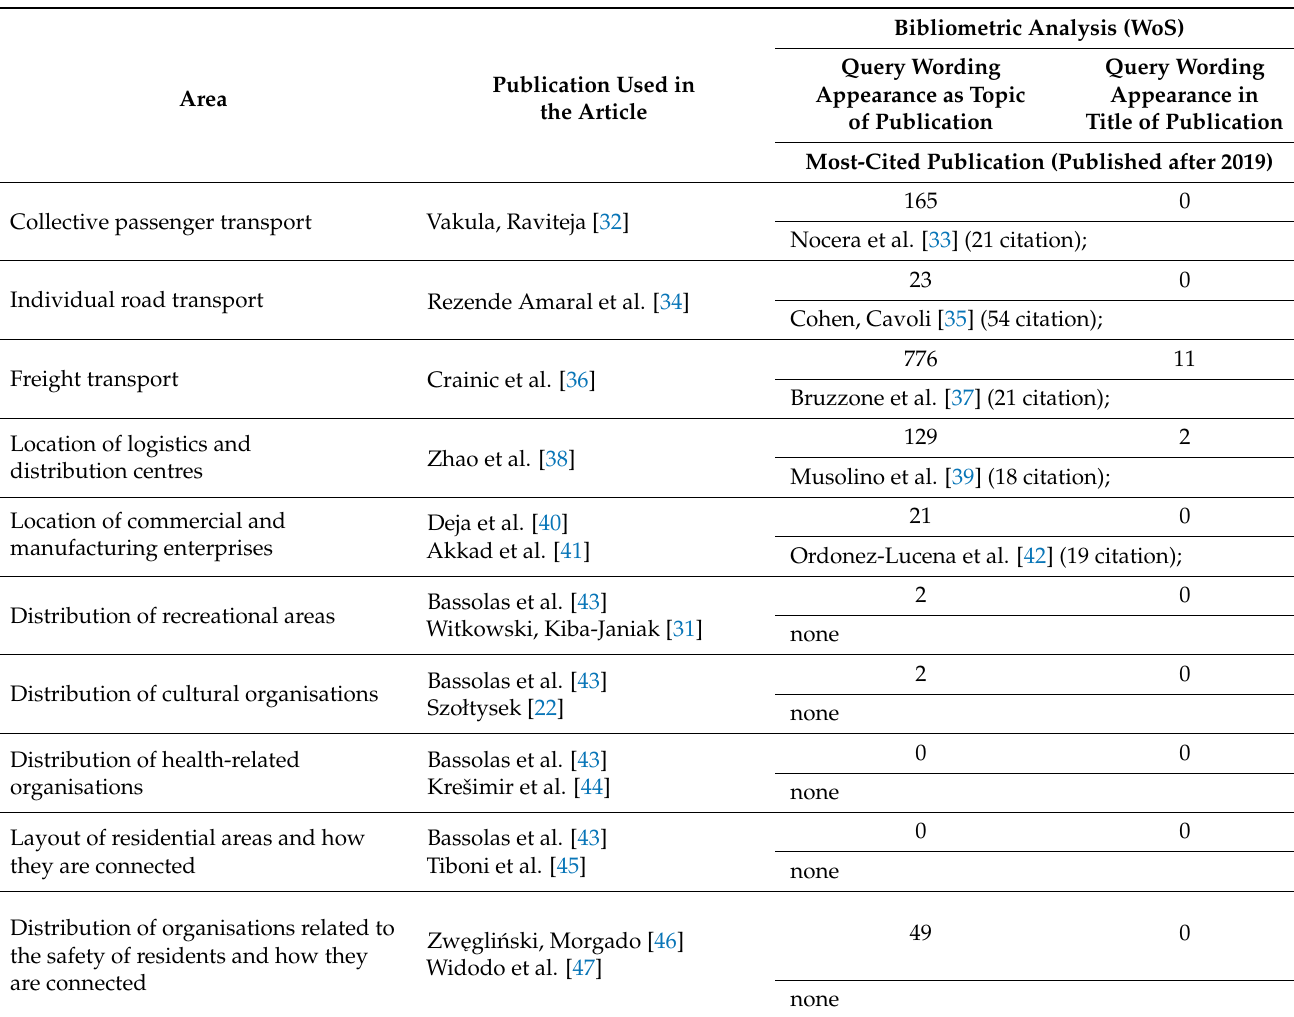
Table 1. Literature analysis supporting the selection of 15